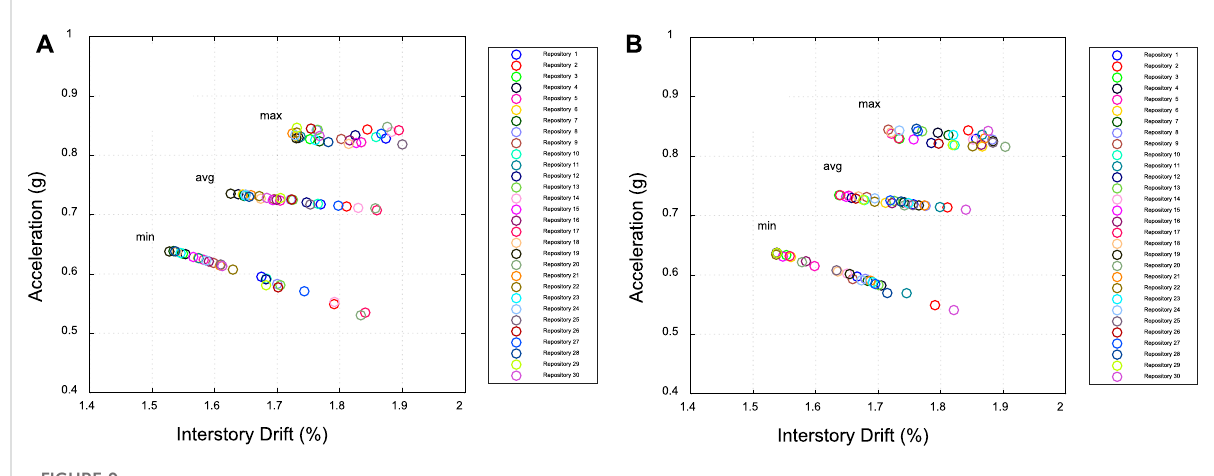
FIGURE 9 Pareto fronts of minima, averages, and maxima of peak responses (i.e., fl oor accelerations and interstory drifts) across all building fl oors/stories for the cases where: (A) “ maximum ” of an EDP is used in cost function, (B) “ average ” of an EDP is used in cost function.